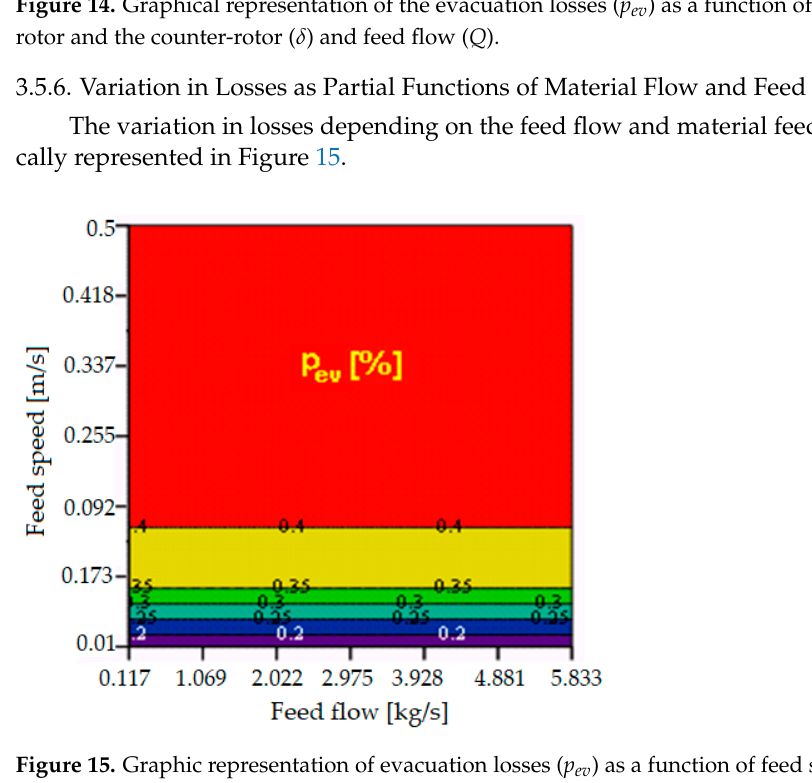
Figure 16. Graphic representation of evacuation losses ( p ev ) as a function of feed speed ( v a ) and feed fl ow ( Q ) . The increase in losses as the feed fl ow increases is normal because a larger amount of material (more straw) is introduced into the thresher and this decreases the intensity of the threshing process and separation, resulting in a larger amount of unseparated seeds.